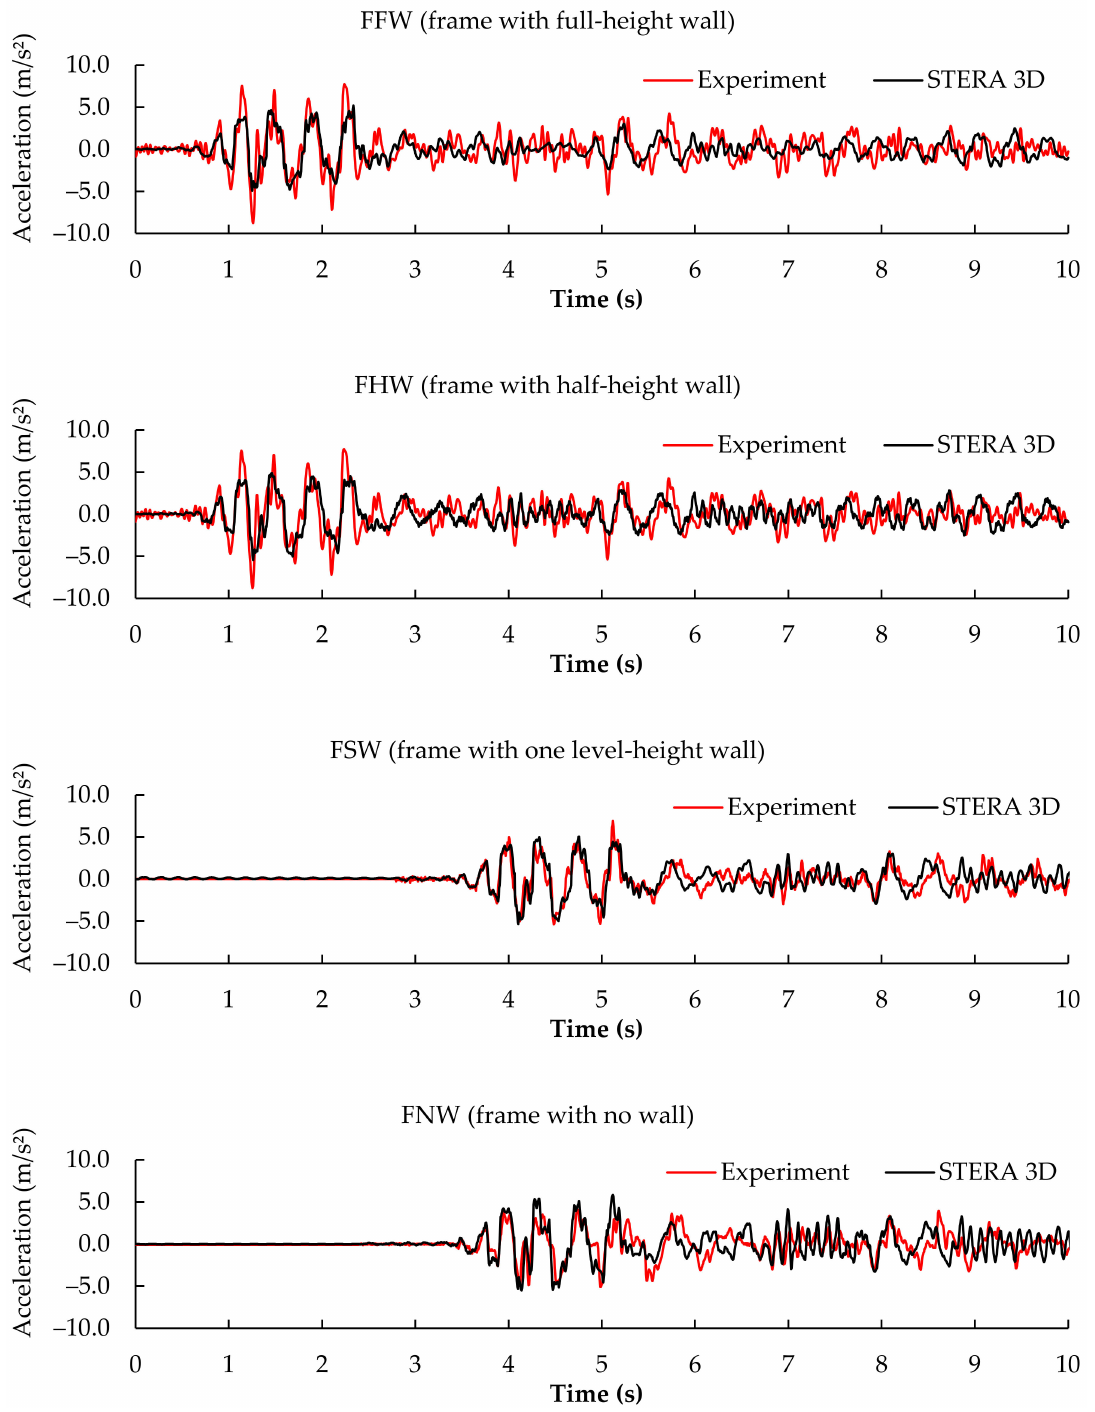
Figure 12. Comparison of acceleration response between Experiment and STERA_3D